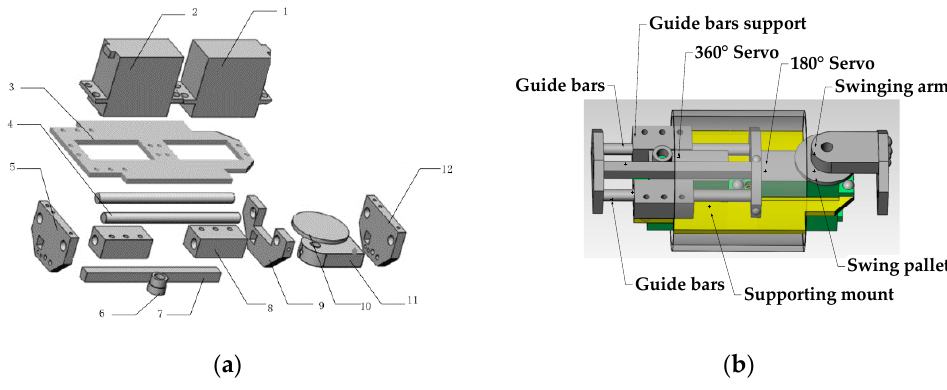
Figure 6. ( a ) Exploded view of snake-like robot. ( b ) Assembly drawing of snake-like robot.